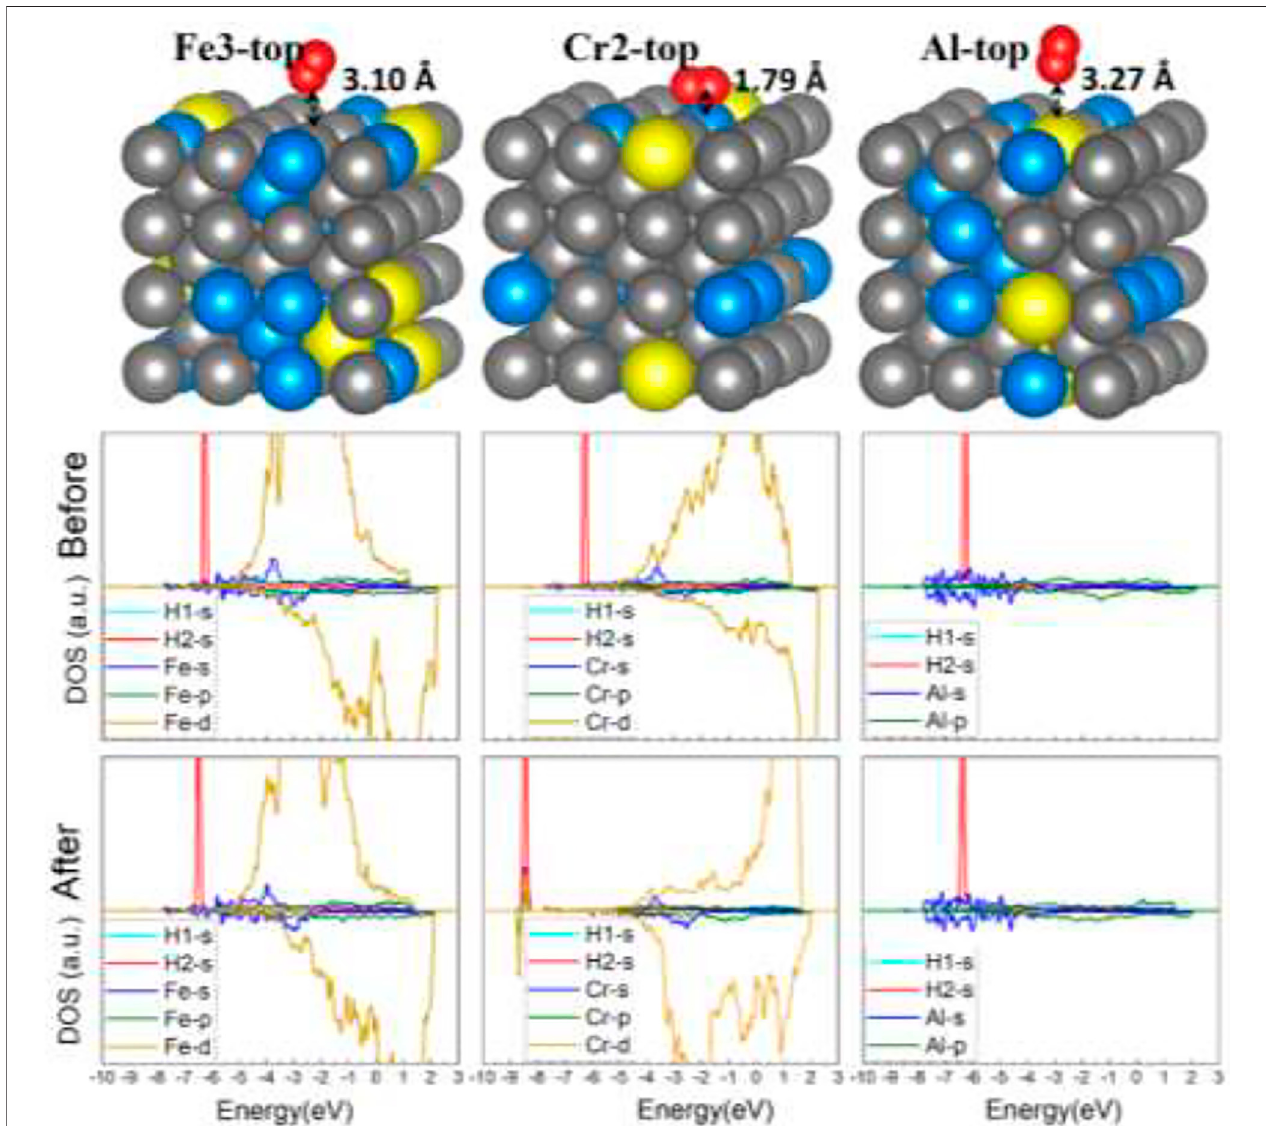
FIGURE 9 | The optimized structures and DOS of H 2 – FeCrAl (100) slabs (three representative adsorption sites: Fe2-top, Cr2-top, and Al-top).